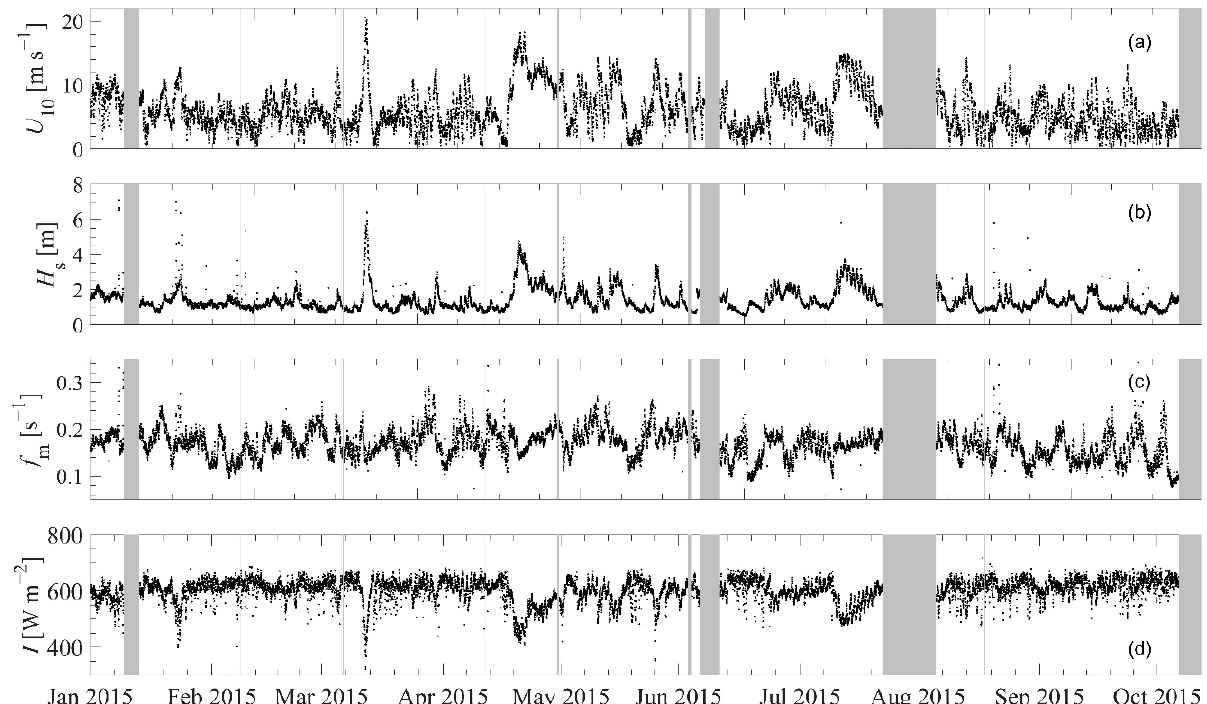
Figure 3. Timeseries of wind and wave properties over 30 min periods: ( a ) The mean wind speed at 10 m reference height, U 10 ( b ) The significant wave height of wind waves, H s . ( c ) The mean wave frequency, f m . ( d ) The attenuated laser intensity of the second laser intensity mode, 𝐼 . Periods where data are unavailable are highlighted in grey.